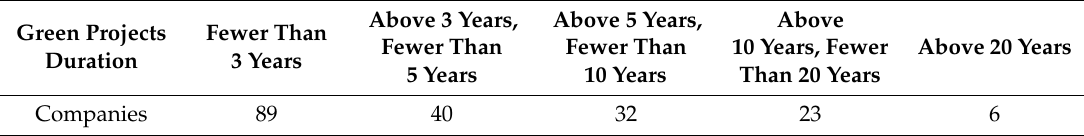
Table 7. Green projects’ duration.